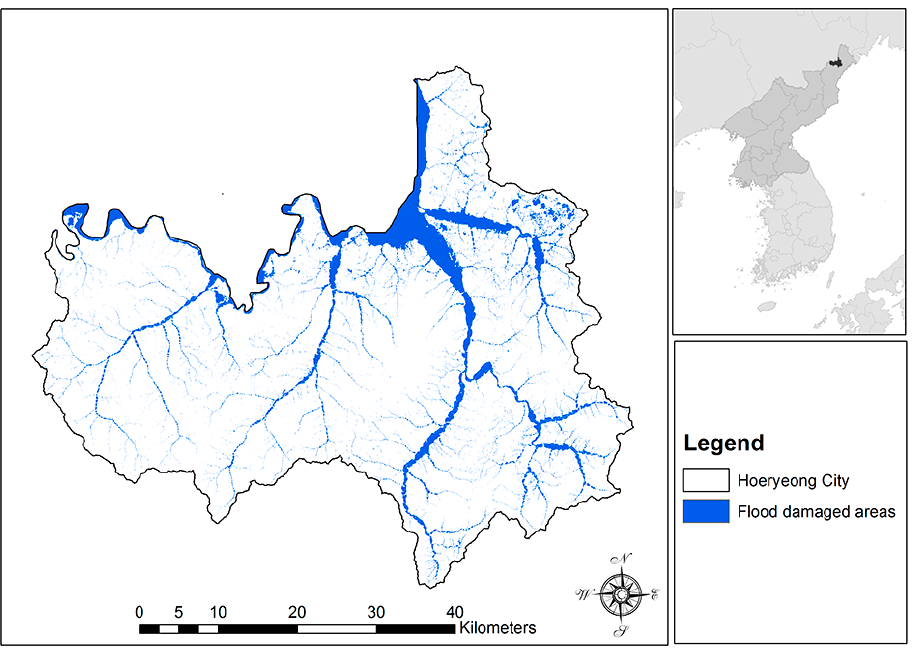
Figure 6. Flood-damaged area map of the study area.